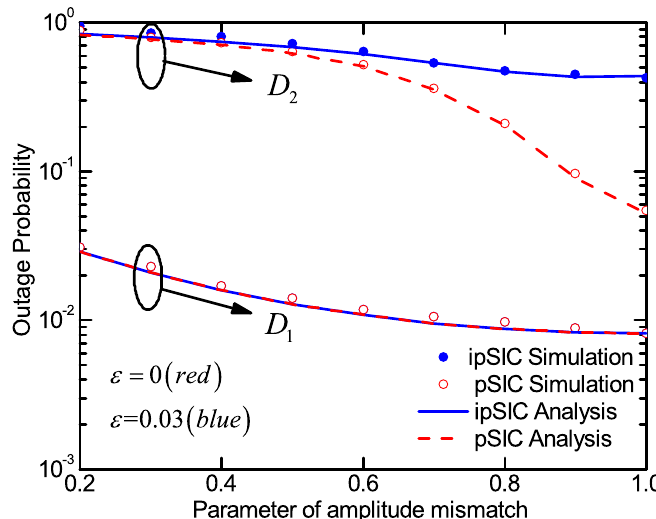
Figure 5. Outage probability versus the amplitude mismatch for the system with ipSIC and pSIC conditions.